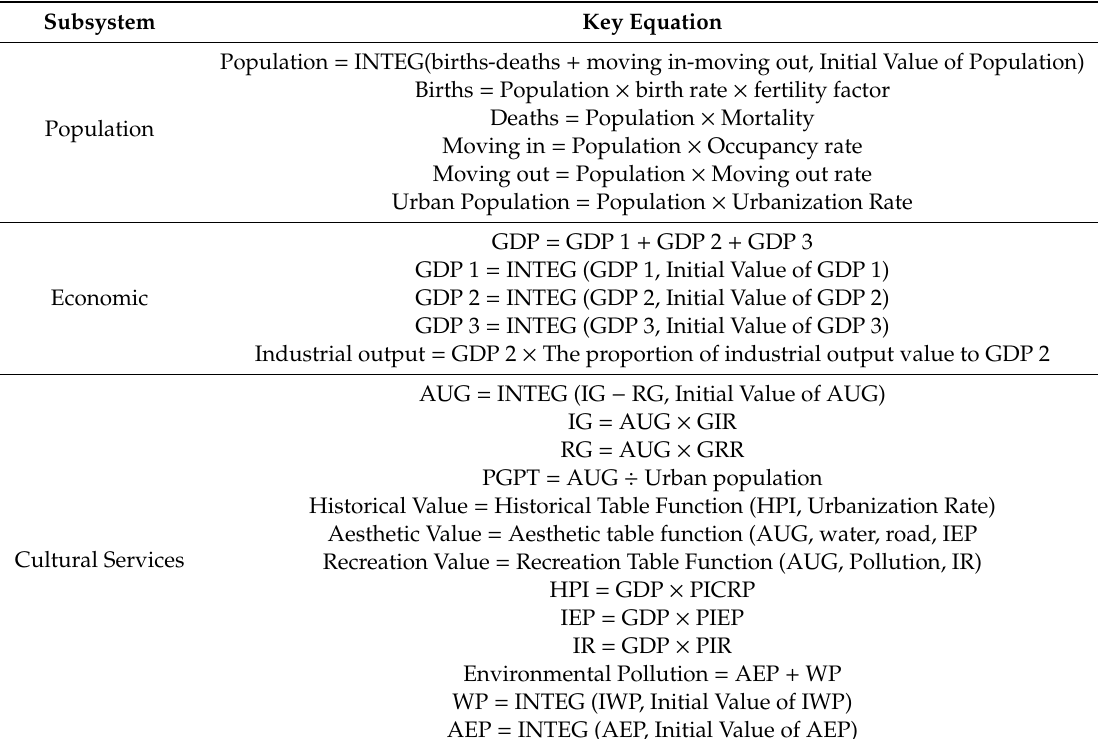
Table 4. Key equations in SD